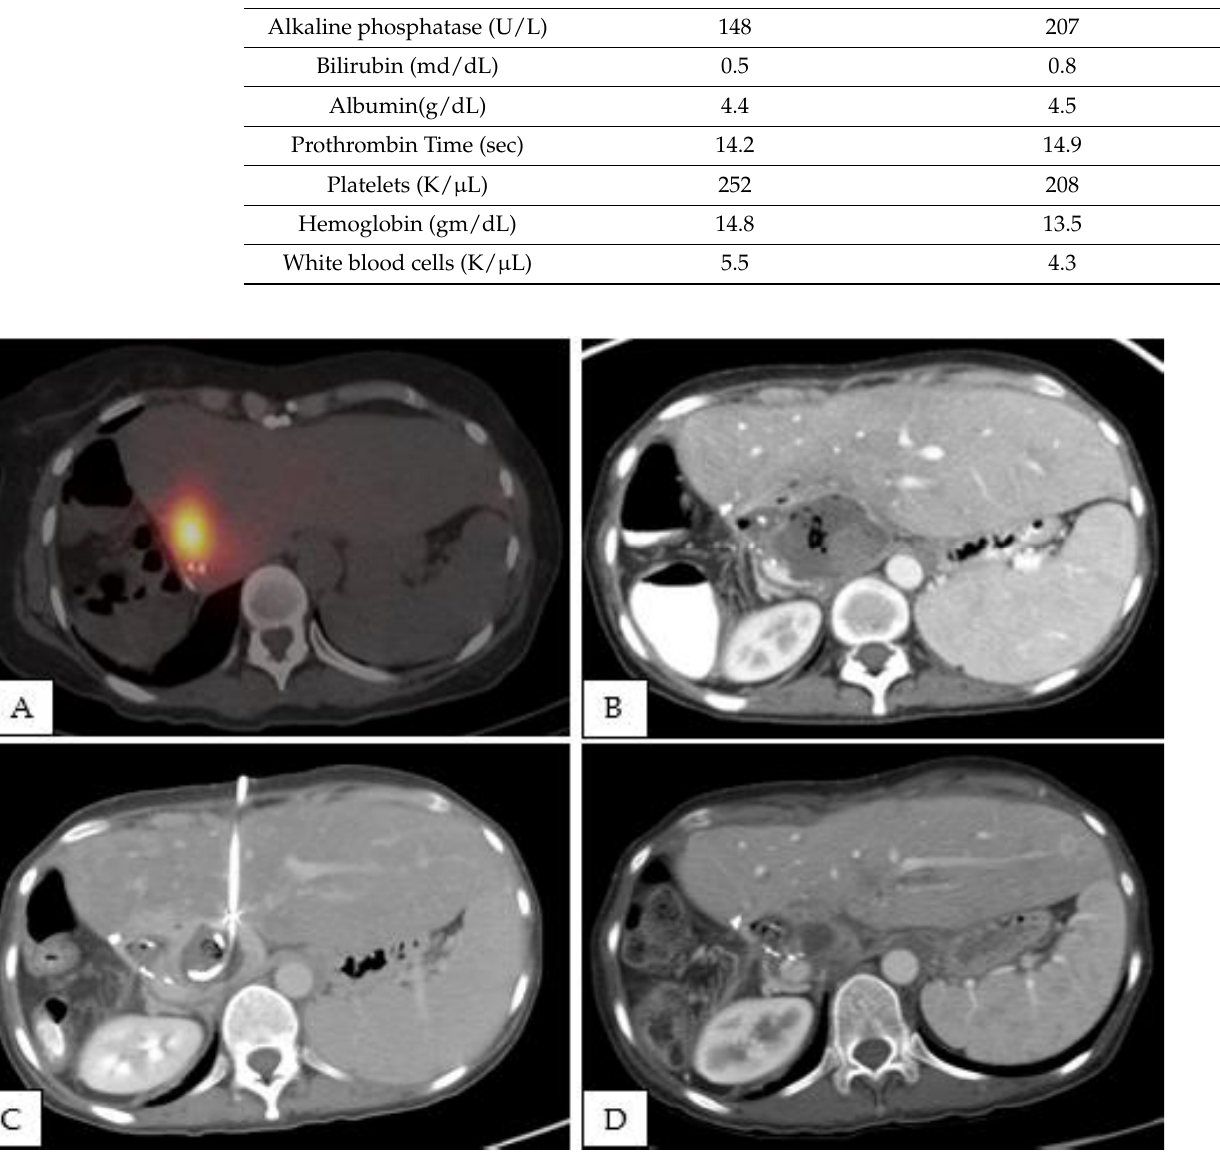
Table 2. Laboratory values before and after the TARE for the patient who developed Liver abscess (Child Pugh A).